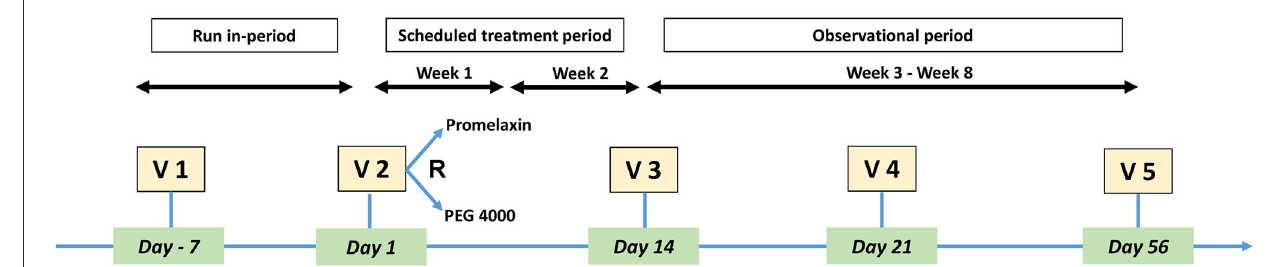
FIGURE 1 | Study Design. The figure depicts the design of the study, including study Visits.